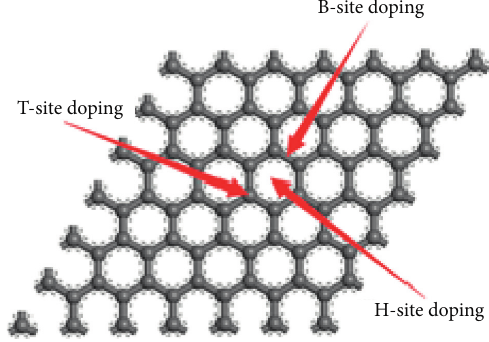
Figure 2: Three possible Mo doping